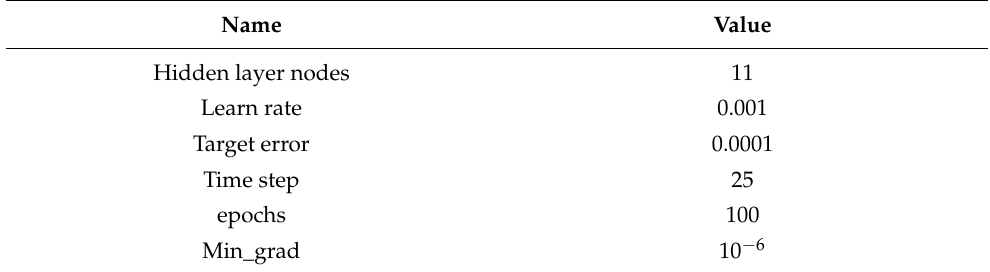
Table 2. BP network parameters.